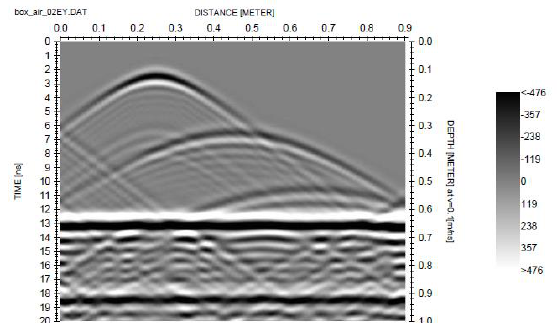
Figure 9. GPR simulation section in a soil box with three iron diffractors at 10, 30 and 50 cm depth and a reflector at 60 cm